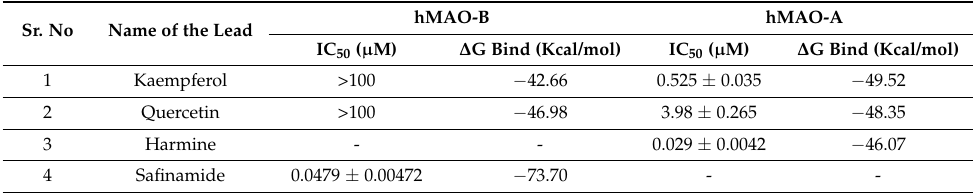
Table 6. Summary of the molecular docking studies and inhibitory activity of compounds against MAO-A and MAO-B enzymes.